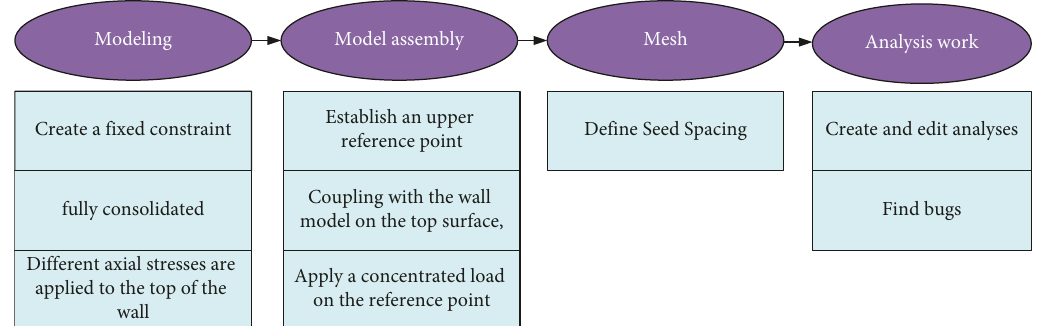
Figure 7: Setting of numerical simulation analysis